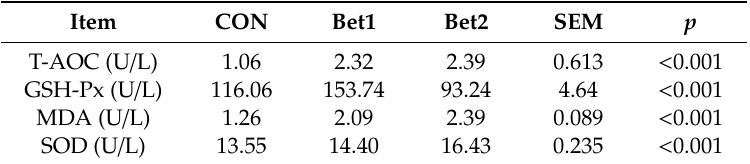
Table 5. Effect of betaine on the serum antioxidant parameters of dairy cows. Table 5. E ff ect of betaine on the serum antioxidant parameters of dairy cows.